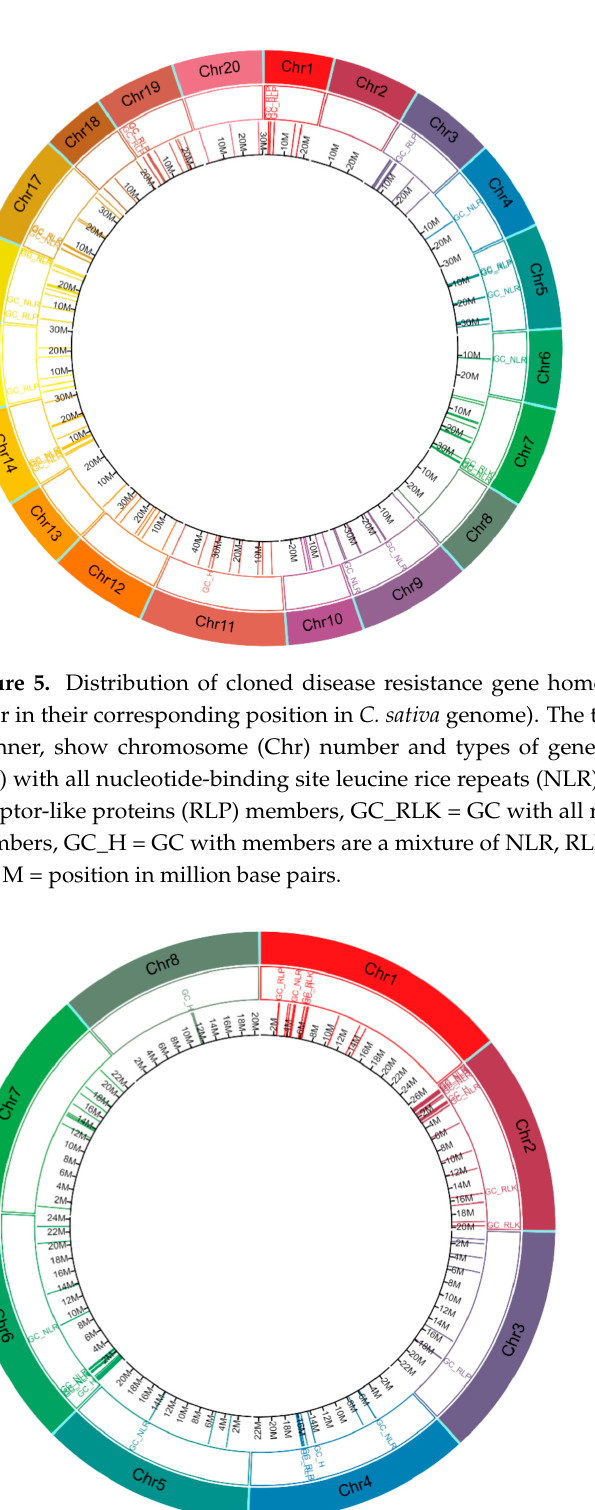
Figure 6. Distribution of cloned disease resistance gene homologs in Cardamine hirsuta (1st inner layer in their corresponding position in C. hirsuta genome). The tracks in the circos plot, from outer to inner, show chromosome (Chr) number and types of gene cluster. GC_NLR = gene cluster (GC) with all nucleotide-binding site leucine rice repeats (NLR) members, GC_RLP = GC with all receptor-like proteins (RLP) members, GC_RLK = GC with all receptor-like kinase proteins (RLK) members, GC_H = GC with members are a mixture of NLR, RLK and/or RLP, Chr = chromosome and M = position in million base